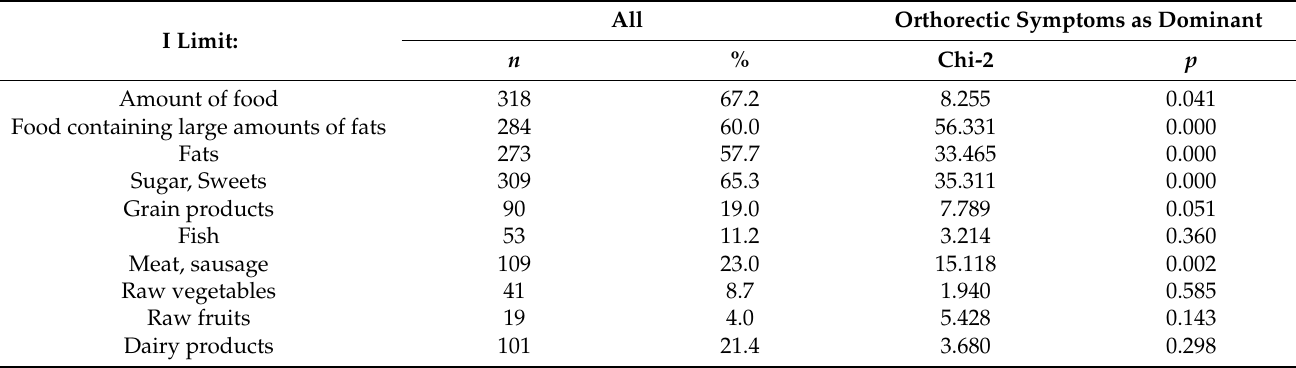
Table 2. Restrictions in consuming specific food products among all of the respondents, based on the ORTO-6 questionnaire.